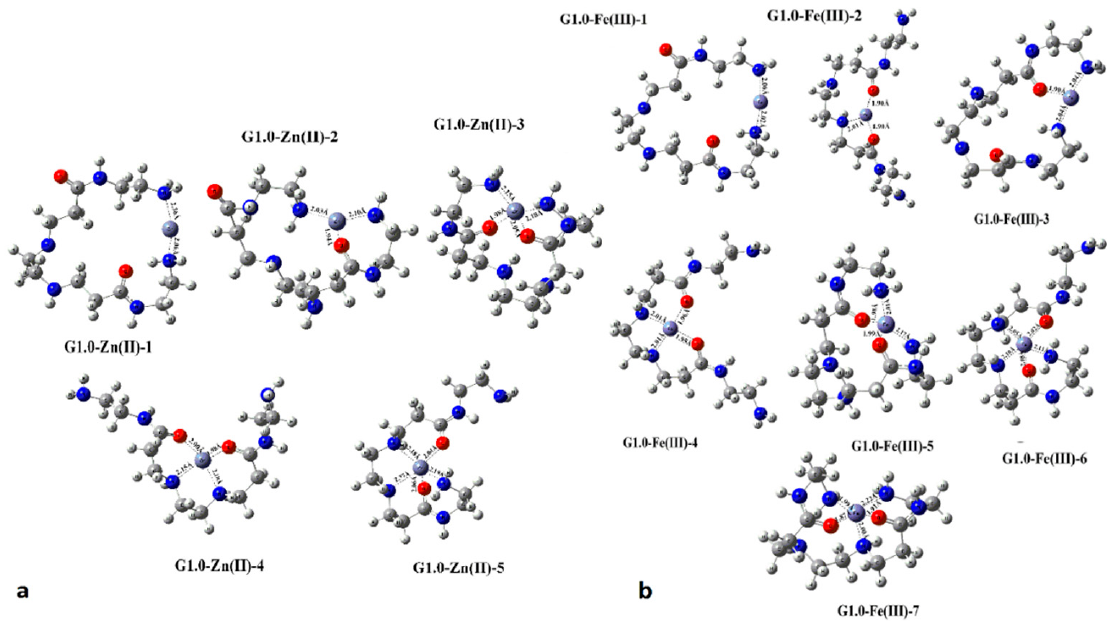
Figure 12. Optimized coordination structures of PAMAM G1.0 with ( a ) Zn(II) (Reproduced with permission from [98]; Copyright Elsevier, 2020) and ( b ) Fe(III) (Reproduced with permission from [103]; Copyright Elsevier, 2018). Addition of n-octadecylisocyanate [97] leads to the introduction of long aliphatic chains to the periphery of the dendrons (Figure 14). In this way, production of amphiphilic silica bearing a hydrophilic dendritic core combined with a hydrophobic surface is obtained and is designed to deal with lipophilic pollutant encapsulation